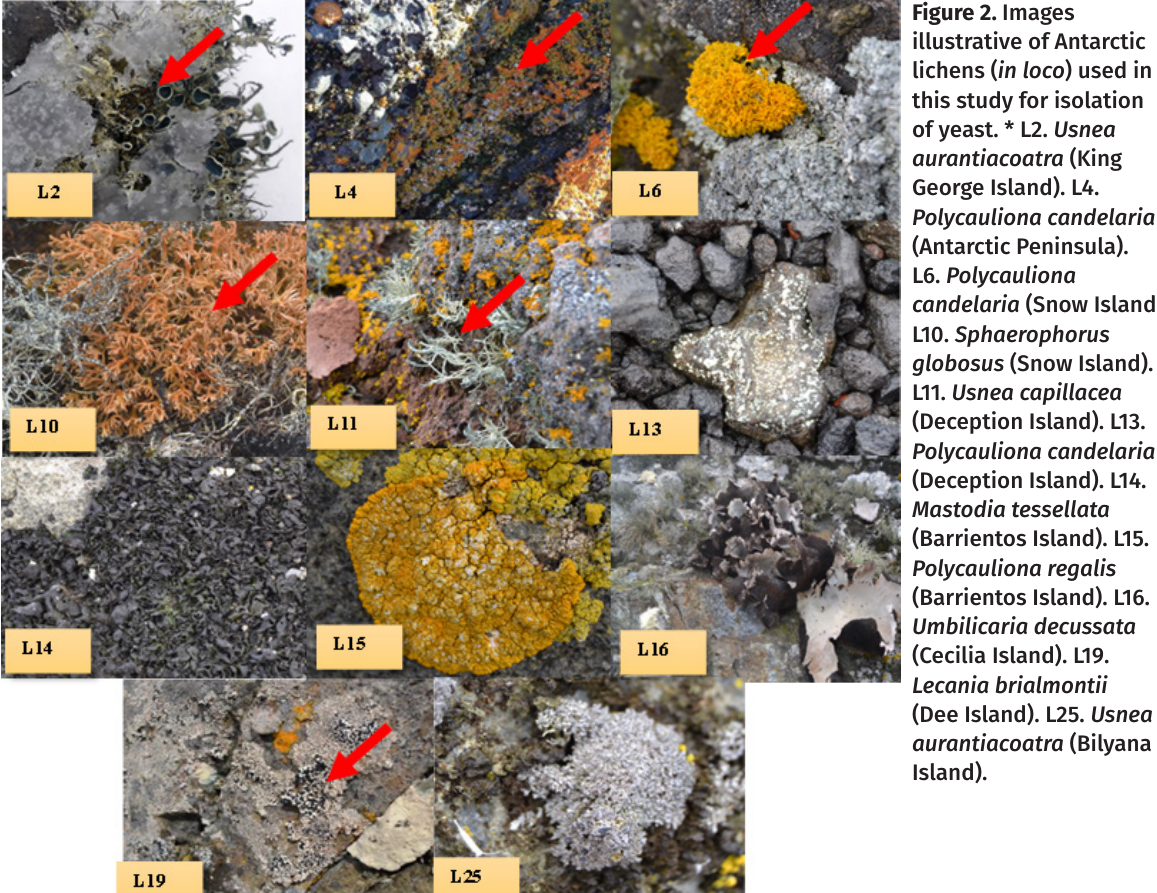
Figure 2. Images illustrative of Antarctic lichens ( in loco ) used